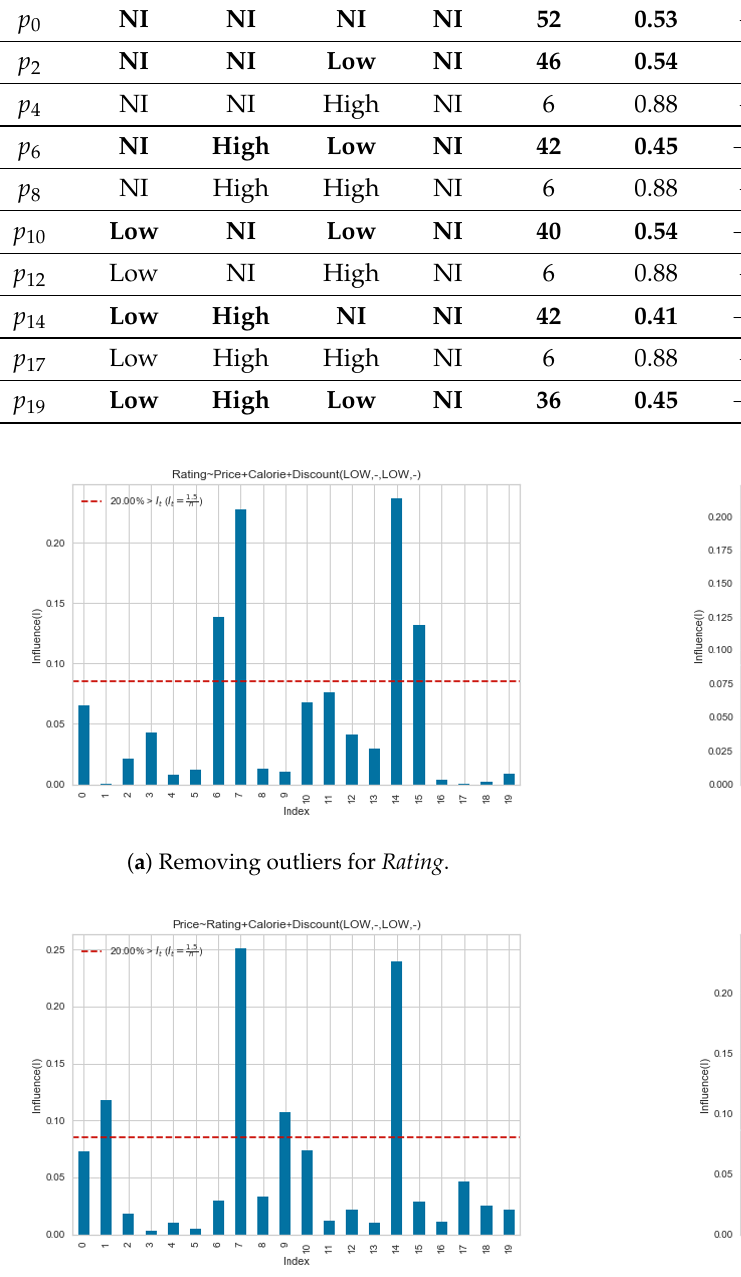
Table A2. Pattern of preference and its correlation PR , PC , PD , RC , RD , CD between attributes. Pref.